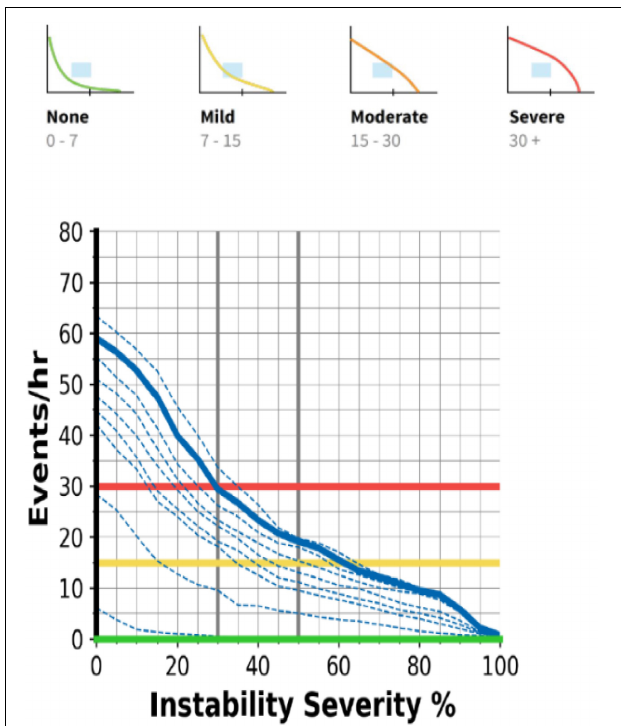
FIGURE 3 | The respiratory instability curves (RIC) discriminate the occurrence, severity, and type of sleep respiratory disorder according to the interception of the target area. See text for